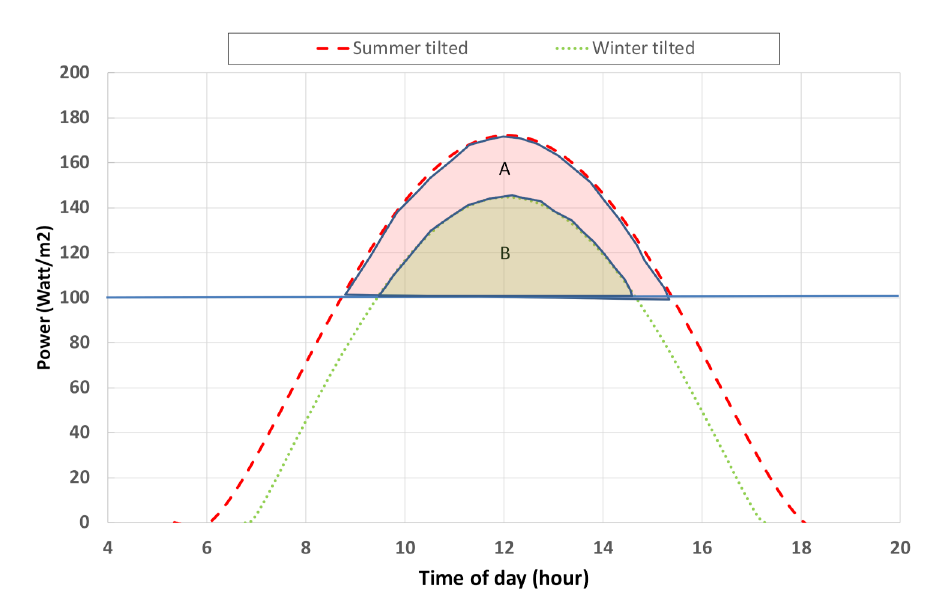
Figure 19. Excess available solar energy for a constant compressor load.